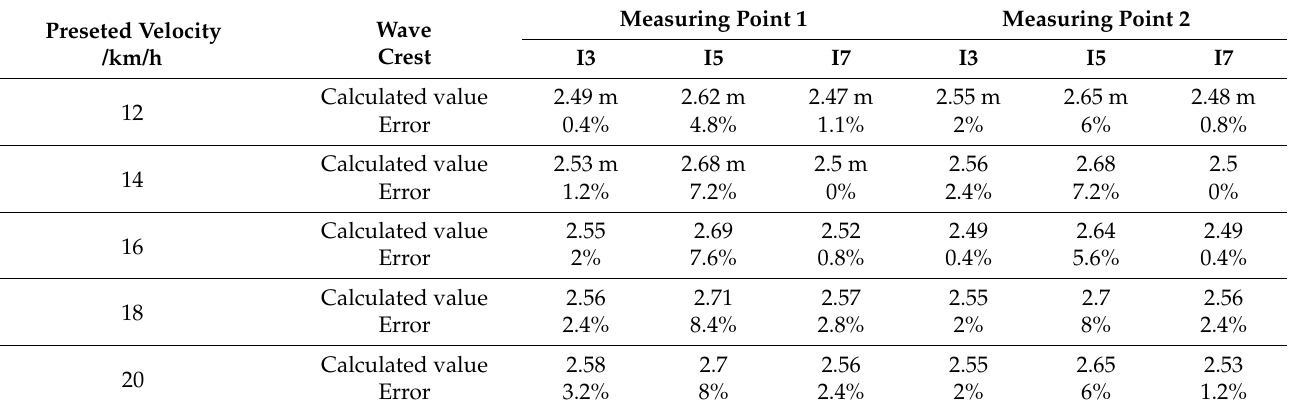
Figure 8. Sensor results of different velocity impact vibrations. Sensor 1: ( a ) 16 km/h, ( b ) 12 km/h, ( c ) 14 km/h, ( d ) 18 km/h, ( e ) 20 km/h; Sensor 2: ( f ) 16 km/h, ( g ) 12 km/h, ( h ) 14 km/h, ( i ) 18 km/h, ( j ) 20 km/h. Table 4. The calculated results of impact